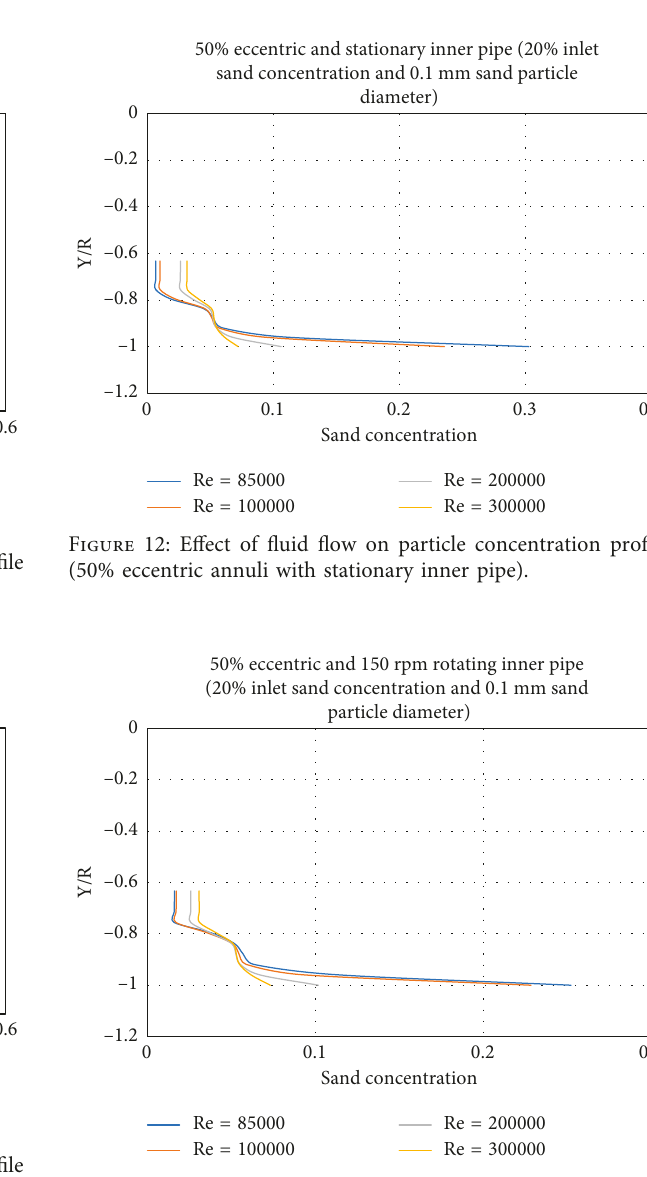
Figure 13: Effect of fluid flow on particle concentration profile (50% eccentric annuli with 150rpm inner pipe).